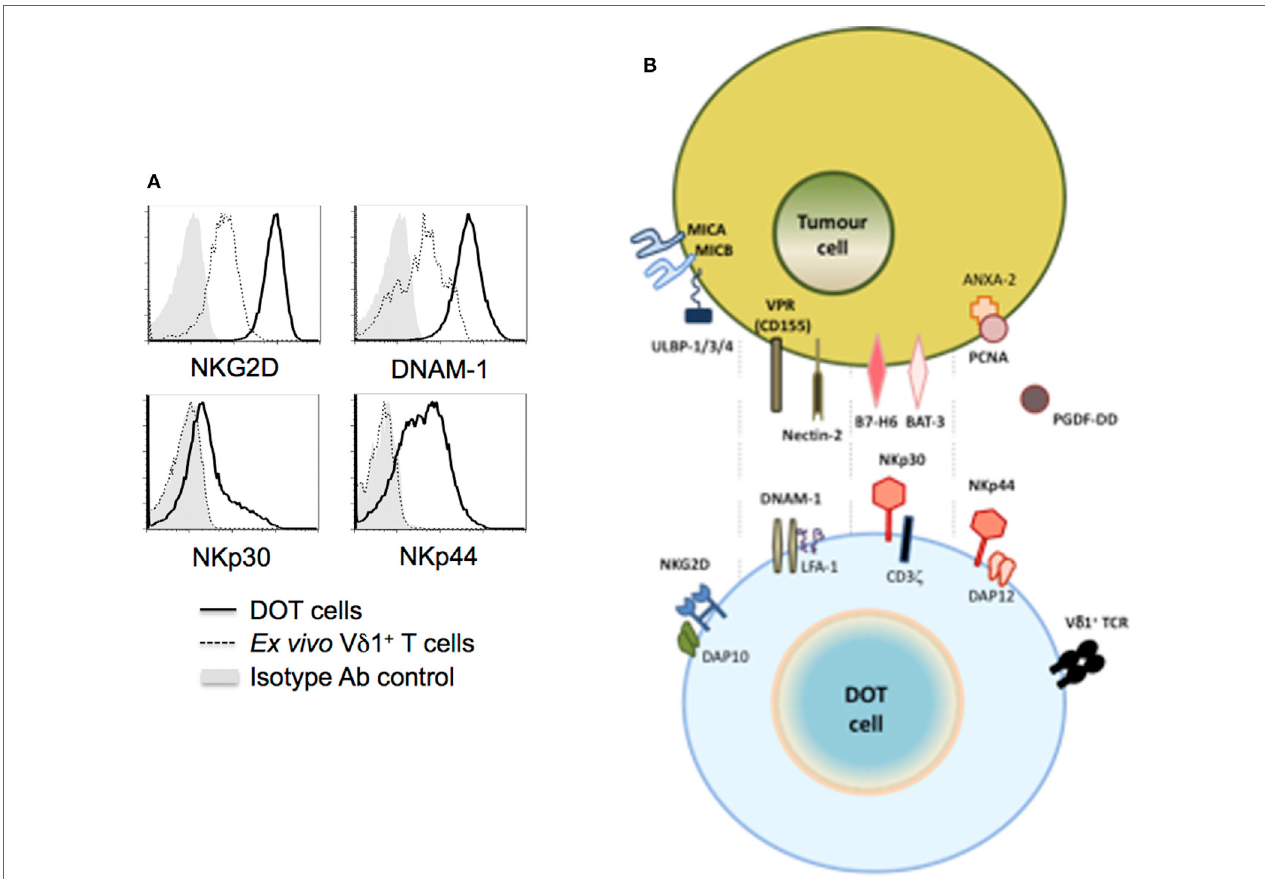
FiGURe 2 | NK cell receptors and ligands for delta one T (DOT) cells. DOT cells are expanded/activated V δ 1 + T cells that upregulate NKG2D and DNAM-1 levels, and induce de novo NKp30 and NKp44 expression [ (A) from Ref. (12)]. (B) The figure depicts putative ligands for those NK cell receptors known to be (over) expressed on tumor